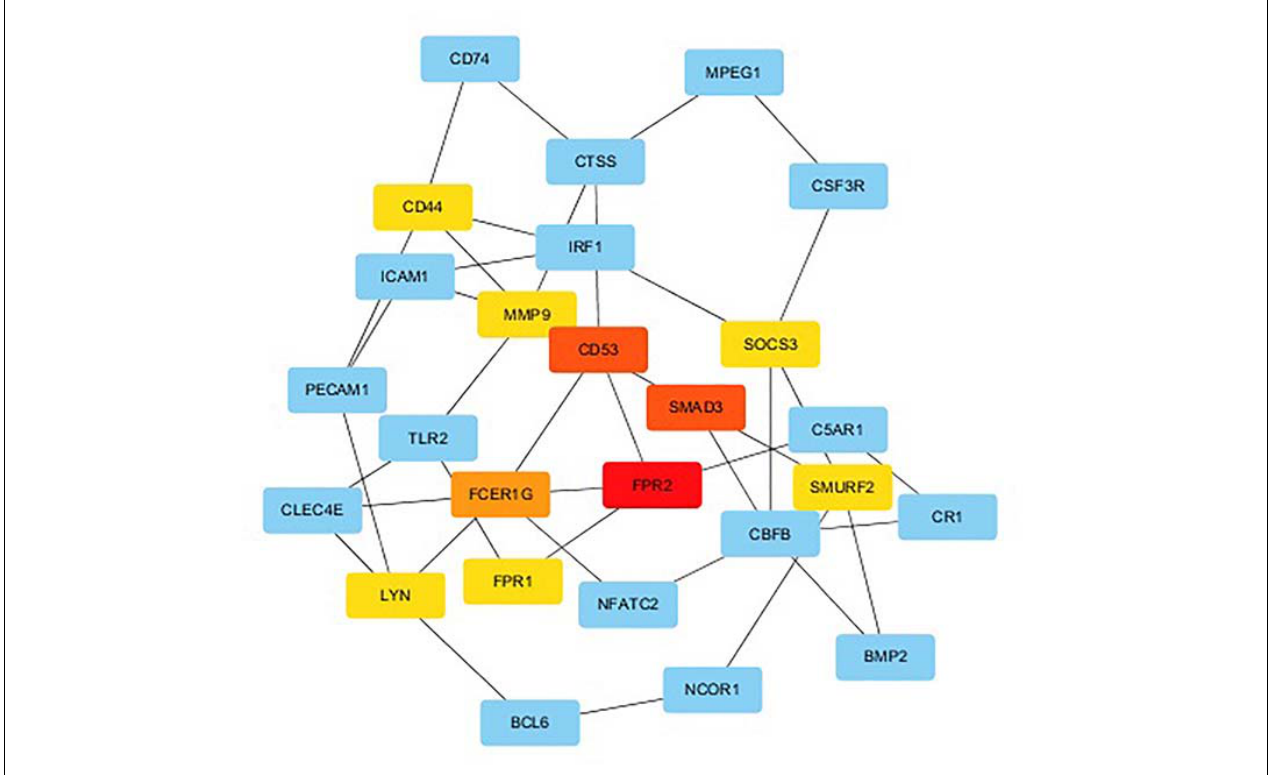
FIGURE 4 | The top 10 hub genes and expanded subnetwork.